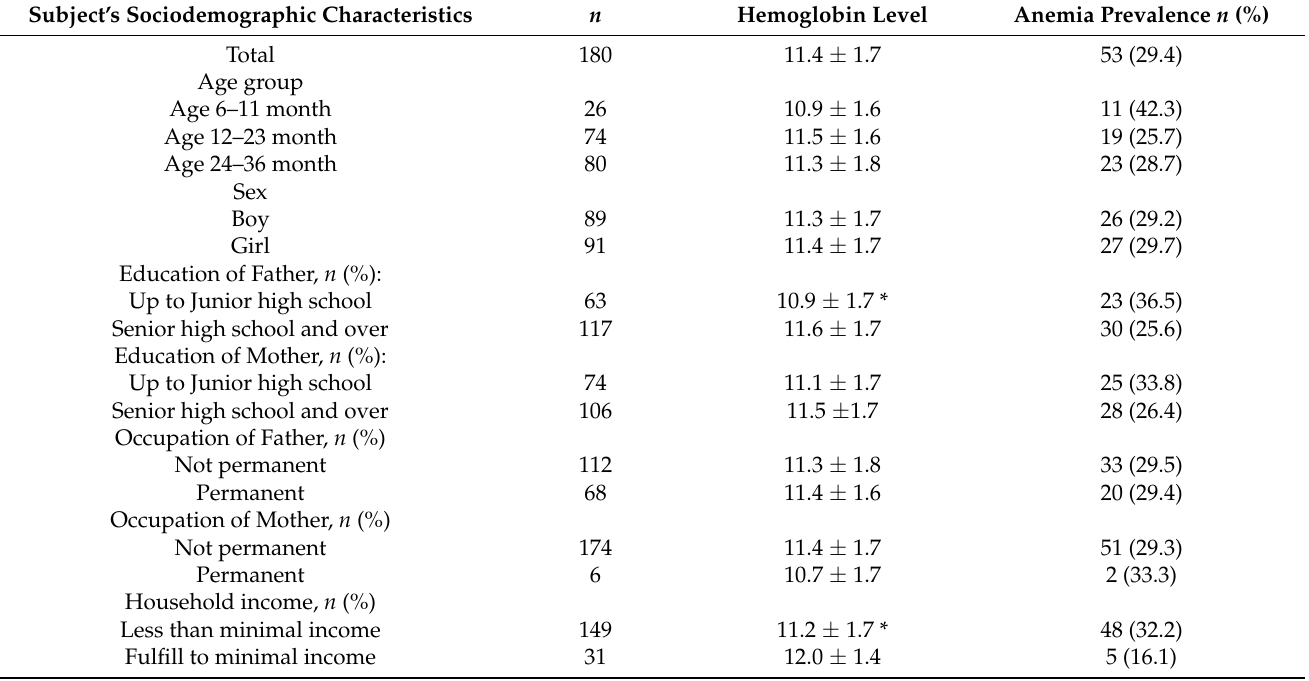
Table 4. Hemoglobin and anemia status of children aged 6–36 months ( n =